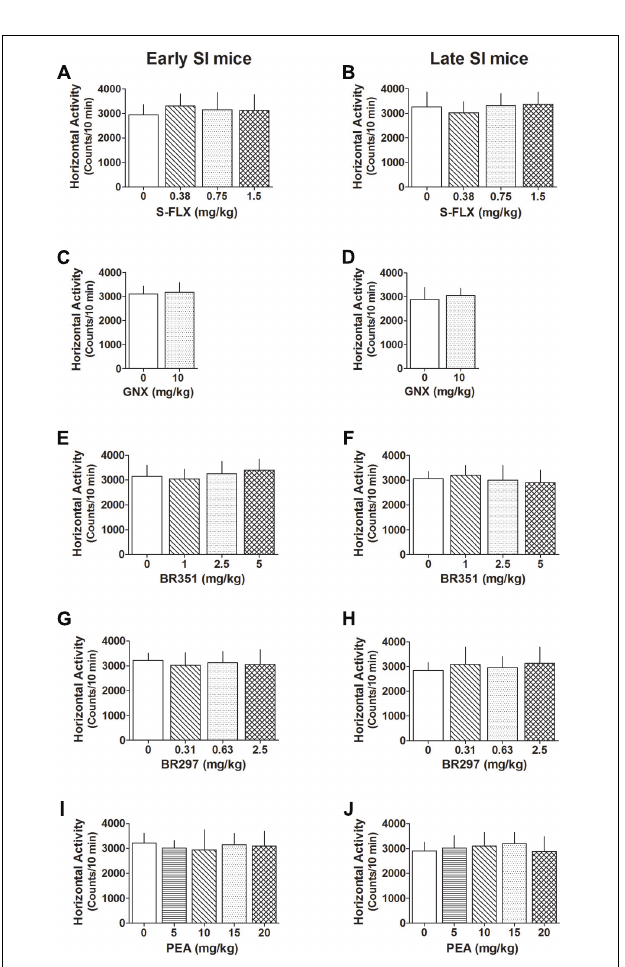
FIGURE 7 | Effect of different drug treatments on locomotor activity both in late and early adolescent SI mice. S -FLX (A,B) , GNX (C,D) , BR351 (E,F) , BR297 (G,H) , and PEA (I,J) were administered to early (left side) and late (right side) adolescent SI mice 60 min before the exposure to the locomotor activity test. All drugs at the dose tested failed to alter locomotion patterns of SI mice. Data represent the mean ± SEM of 7–18 mice.